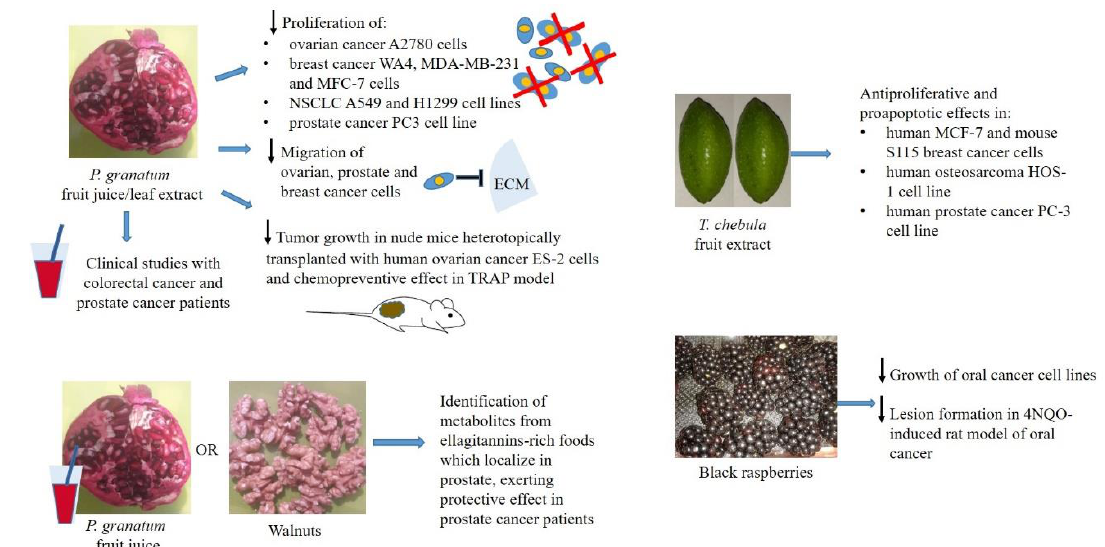
Figure 1. Experimental evidence of the chemopreventive and therapeutic effects of EA derived from dietary fruits. ECM, extracellular matrix; ↓ , inhibition.